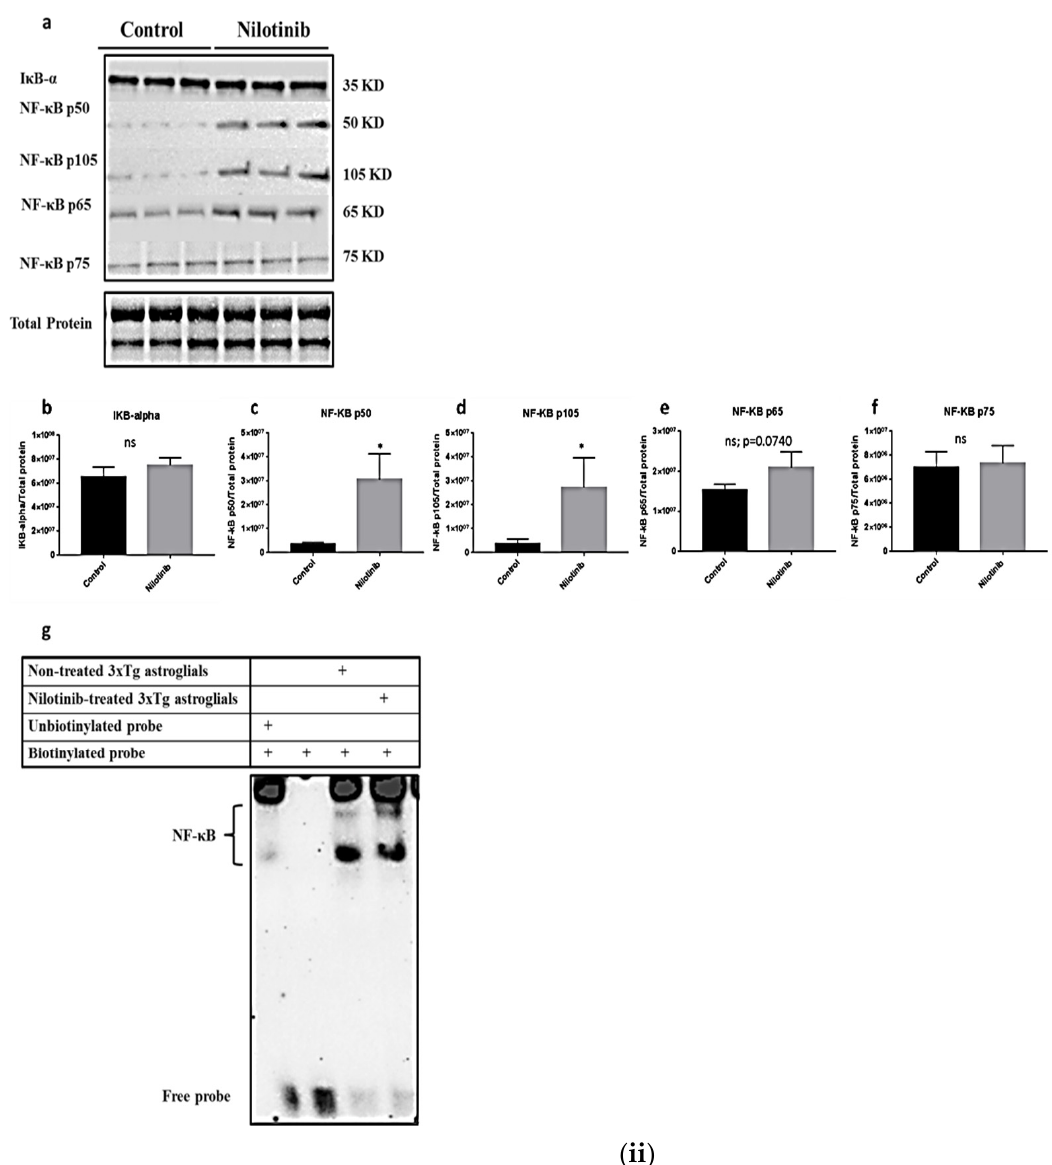
Figure 3. ( i ) Nilotinib significantly increased the activation of NF- κ B and expression of NF- κ B p50/p105 subunits in C57BL/6-WT astroglia. ( a ) Western blot experiments demonstrating relative levels of NF- κ B subunits (p50, p105, p65, and p75), and I κ B- α in cultured cortical astroglia derived from C57BL/6 in the presence and absence of 24 h 100 nM nilotinib treatment. ( b–f ) Relative quantification for protein levels of NF- κ B subunits (p50, p105, p65, and p75) and I κ B- α normal-